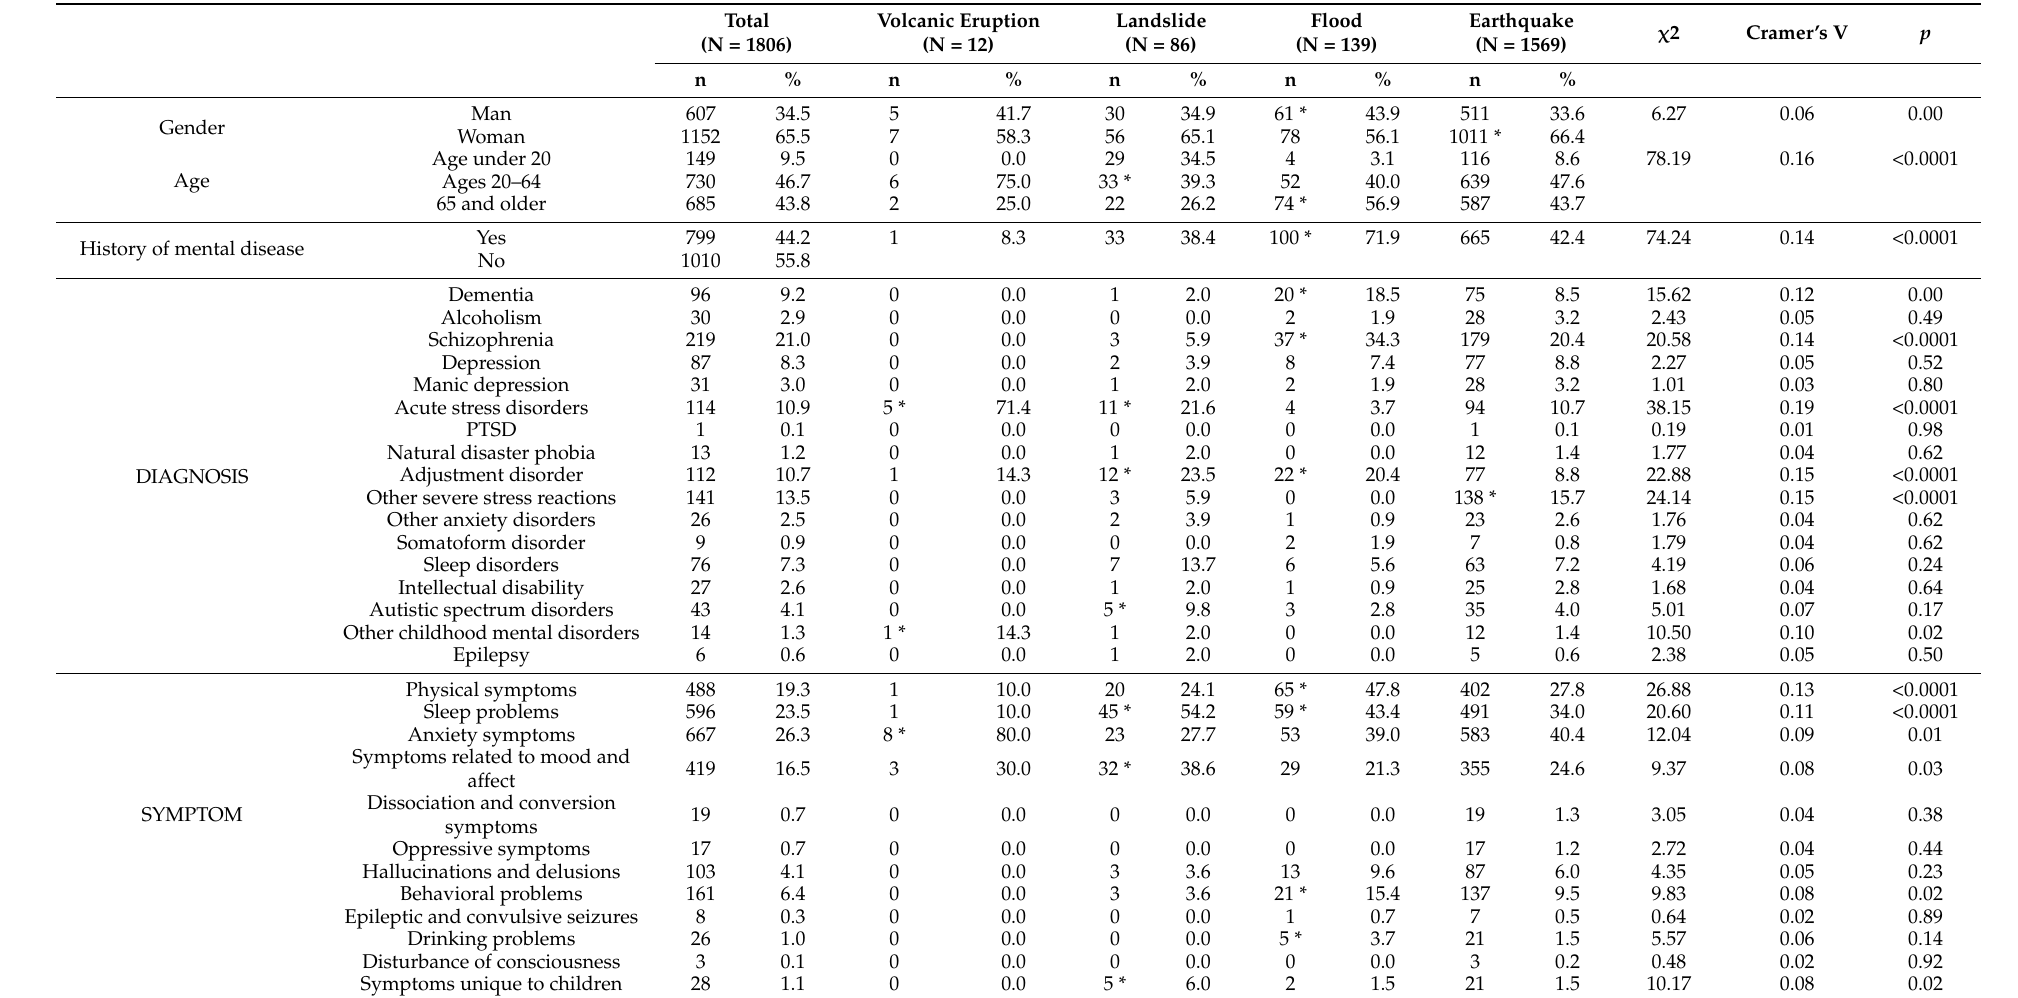
Table 1. Comparison of the Basic Attributes, Diagnoses, and Symptoms of the Target Population by